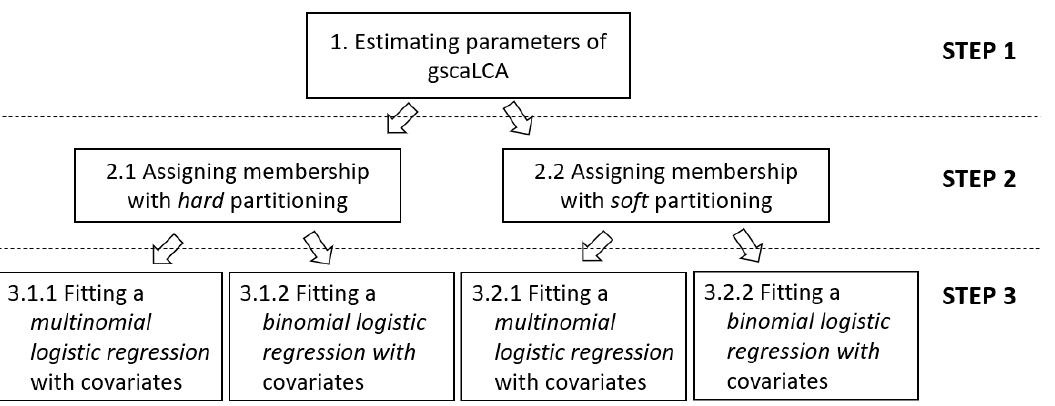
Figure 1. Flow chart of three-step approach with the Generalized Structured Component Analysis for Latent Class Regression (gscaLCR) algorithm: (Step 1) Estimating parameters of gsca with latent class analysis (gscaLCA), (Step 2) Assigning the membership, and (Step 3) Estimating the effect of covariates.